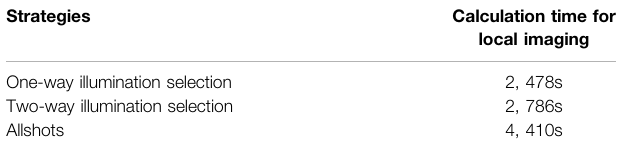
Table 1 | Calculation ef fi ciency